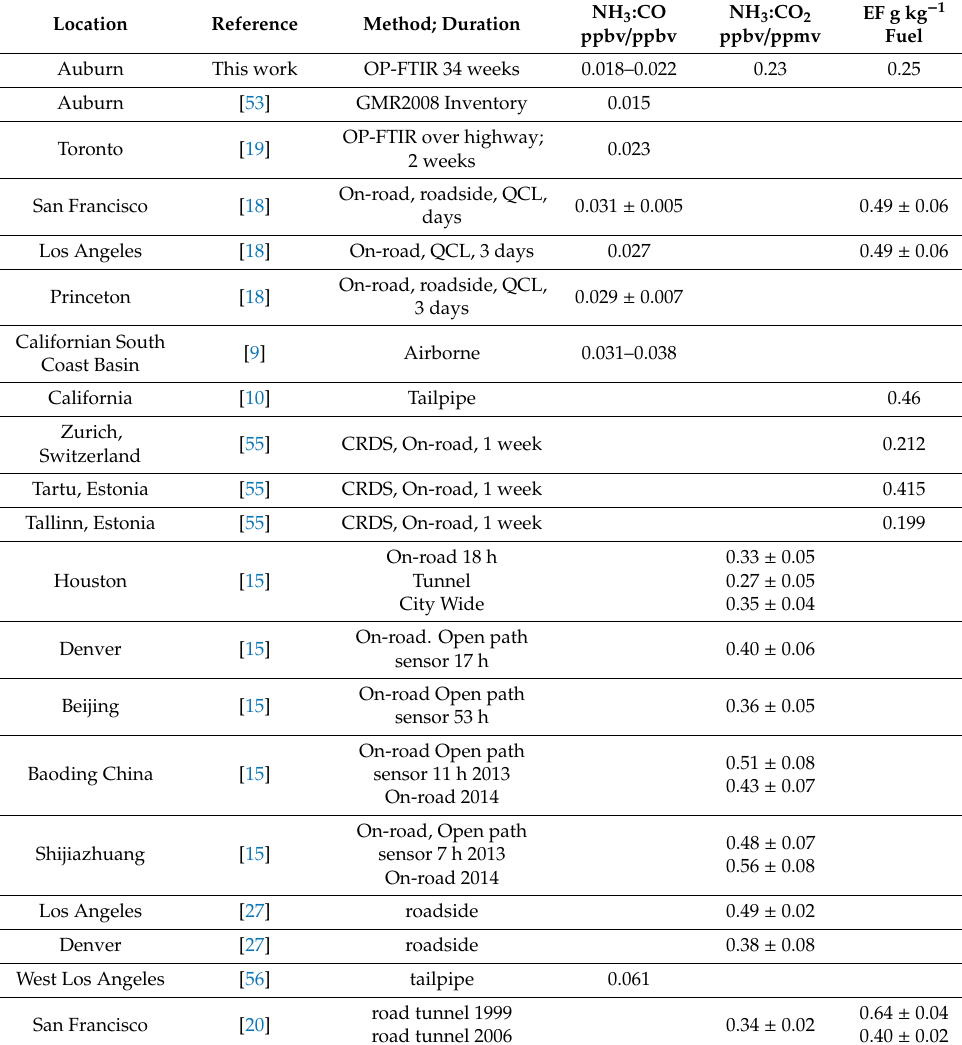
Table 7. Comparison of measurements of vehicular emissions of NH 3 :CO, NH 3 :CO 2 and emission factors, including the location, type and duration of the